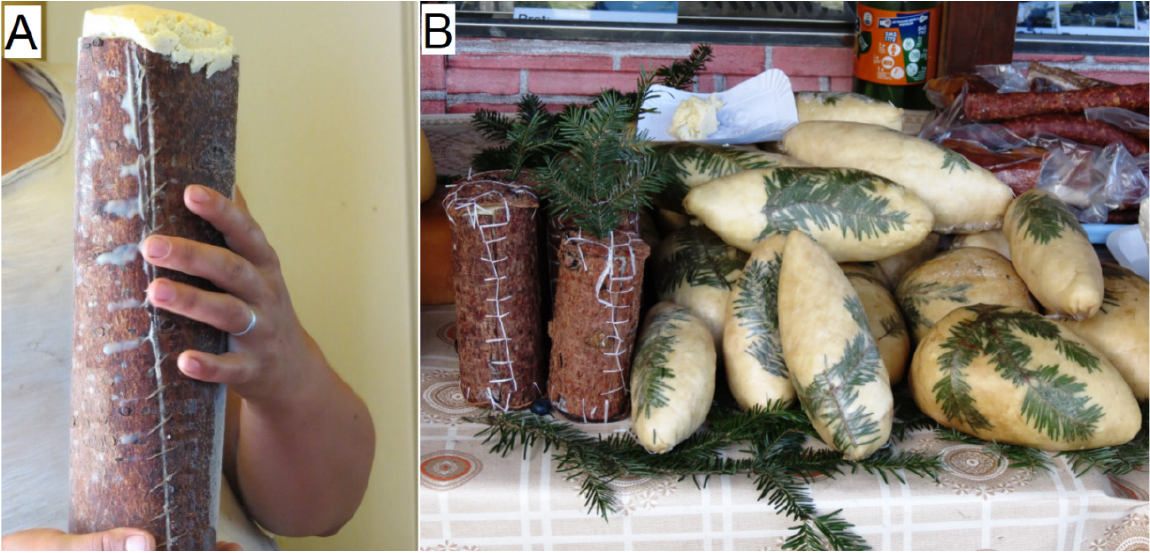
Figure 3. ( A ) Cottage cheese container made of bark of pine species (in Cinod) and ( B ) Pine needles for cheese conservation.